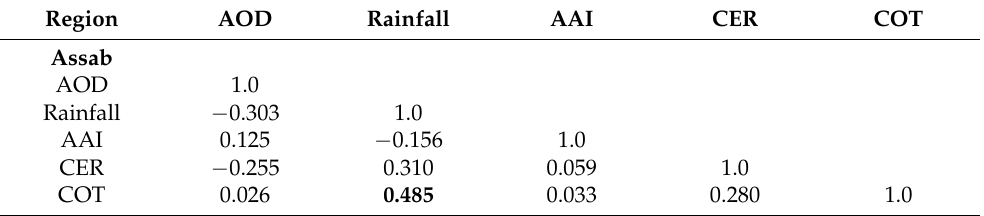
Table 8. The correlation coefficient values between AOD, rainfall, AAI, CER, and COT over Assab in JJA between 2001 and 2018. The correlation coefficient (R) value ≥ 0.468 (critical R-value) is highlighted in bold.